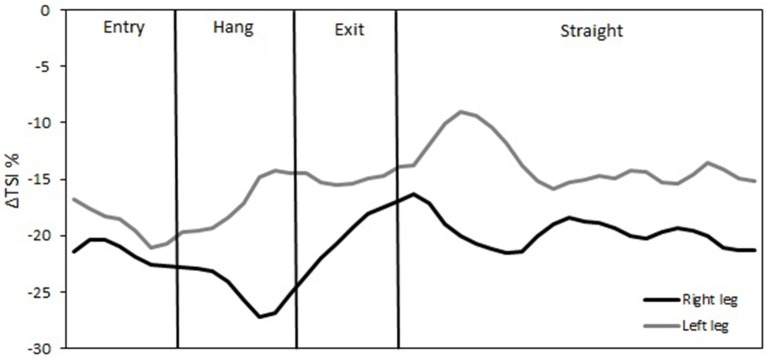
Δ Tissue saturation index (%) in one lap during short-track speed skating. The straight in short-track speed skating contains one glide on each blade (both legs on-ice). The corner in short-track speed skating contains three subsections in the following order: an entry at which the skater performs leg crossovers, a hang in which the skater travels around the apex of the corner supported solely on the right blade, and an exit involving leg crossovers.